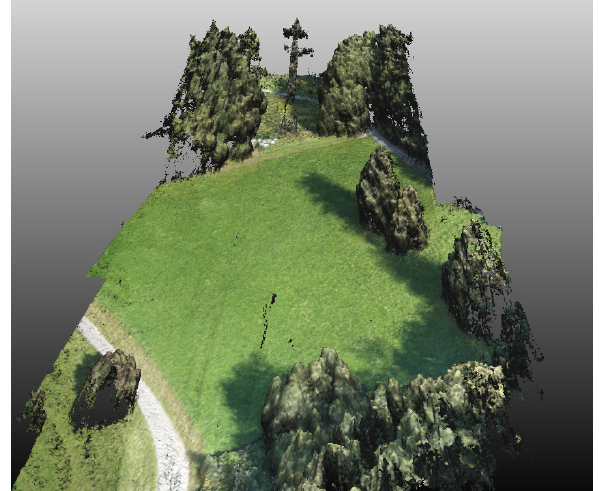
Figure 10. Dense reconstruction of Set1: It can be seen, that the vegetation is reconstructed accurately and the semantically filtered power lines are not reconstructed.